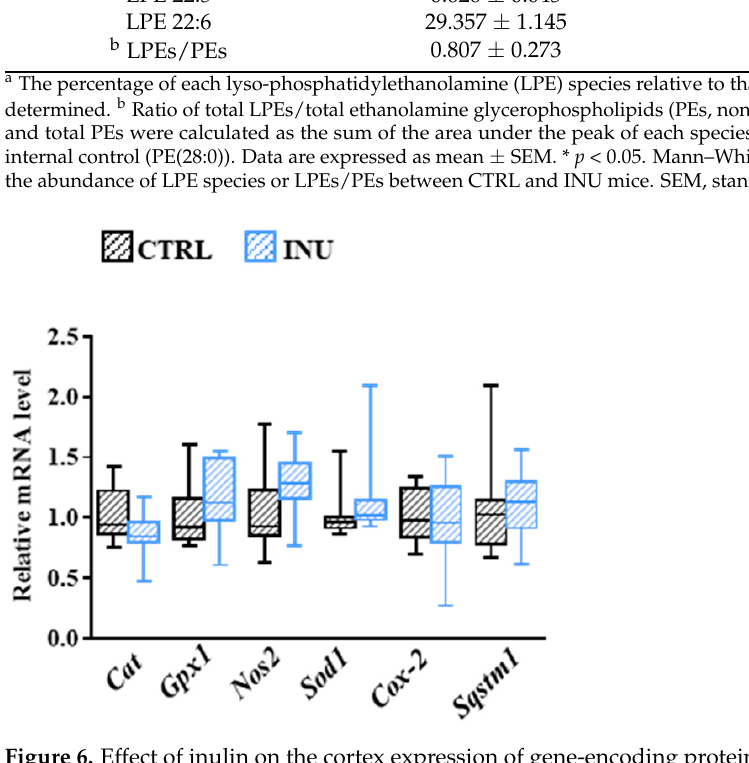
Figure 6. Effect of inulin on the cortex expression of gene-encoding proteins involved in oxidative stress-related mechanisms. Cat encodes catalase, Gpx1 encodes glutathione peroxidase 1, Nos2 encodes inducible nitric oxide (NO) synthase, Sod1 encodes superoxide dismutase (Cu-Zn), Cox-2 encodes cyclooxygenase-2, and Sqstm1 encodes sequestosome-1 (ubiquitin-binding protein p62). The levels of mRNA were normalized to Hprt mRNA level for calculation of the relative levels of transcripts. mRNA levels are illustrated as fold change. Data are presented in box and whisker plot format (median; min. to max.). The Mann–Whitney test was used for comparison of the level of each mRNA between CTRL and INU mice.